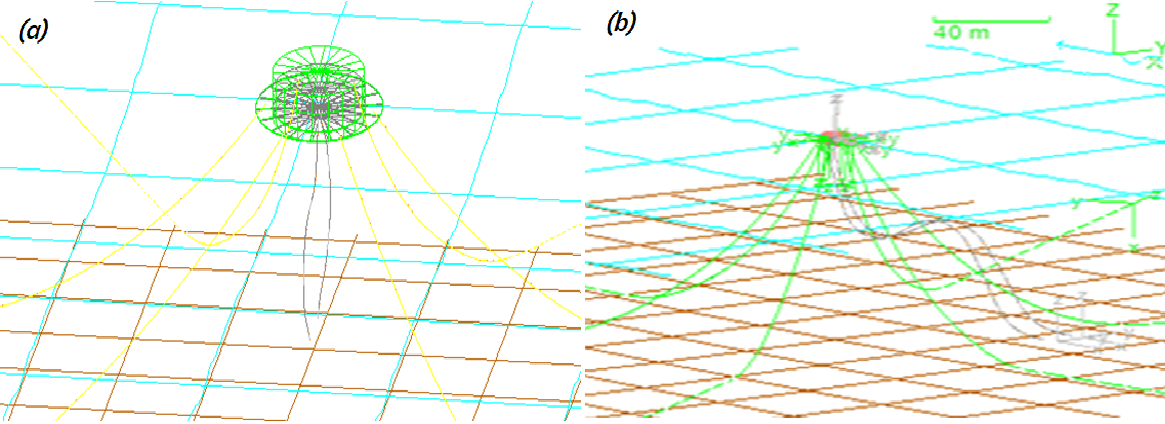
Figure 12. CALM buoy finite element model of ( a ) Chinese-lantern and ( b ) Lazy-S configurations.